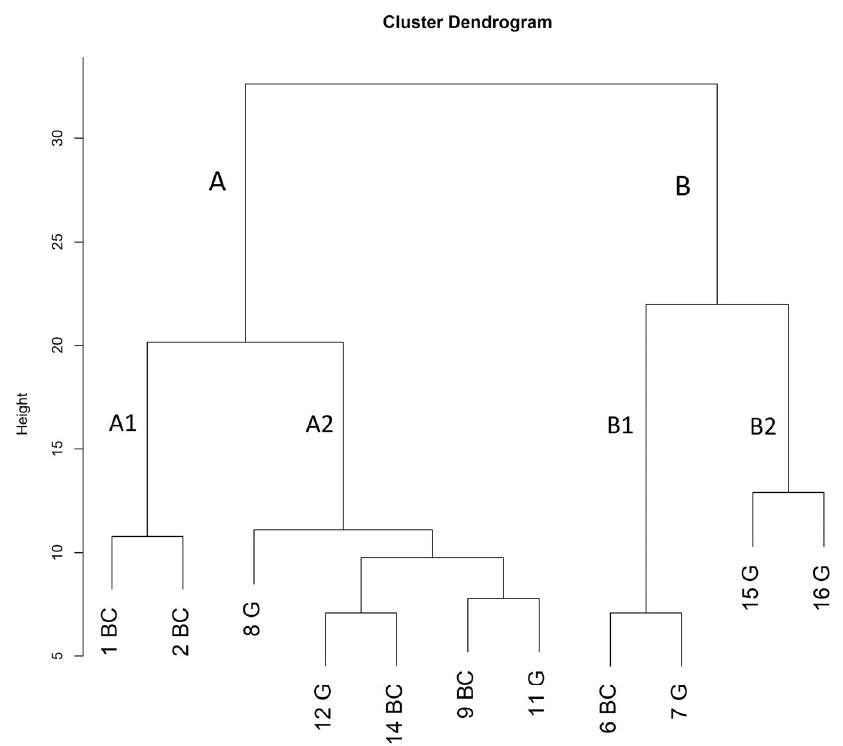
Figure 5. Cluster analysis based on non-standardized relative percentage data of foraminifera > 3% at least on the sample. The dendrogram evidences two major groups (A and B). Both can be subdivided into two additional (cluster A1, A2, B1, B2) representing similarities in the faunistic content of the investigated samples (x axis).